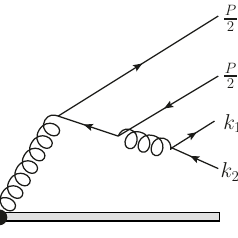
Figure 3 . Typical Feynman diagrams for g ! Q (cid:22) Q ( 1 S [1 ; 8] obtained by permuting the heavy quark and anti-quark or the two emitted gluons.